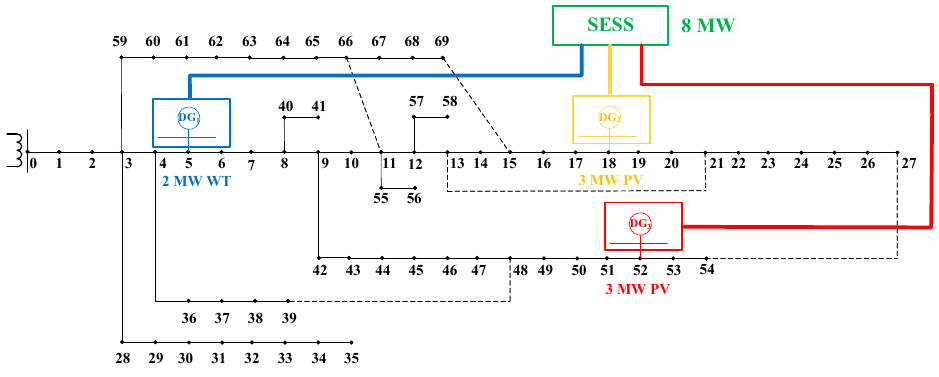
Figure 3. PG&E 69-bus system topology.